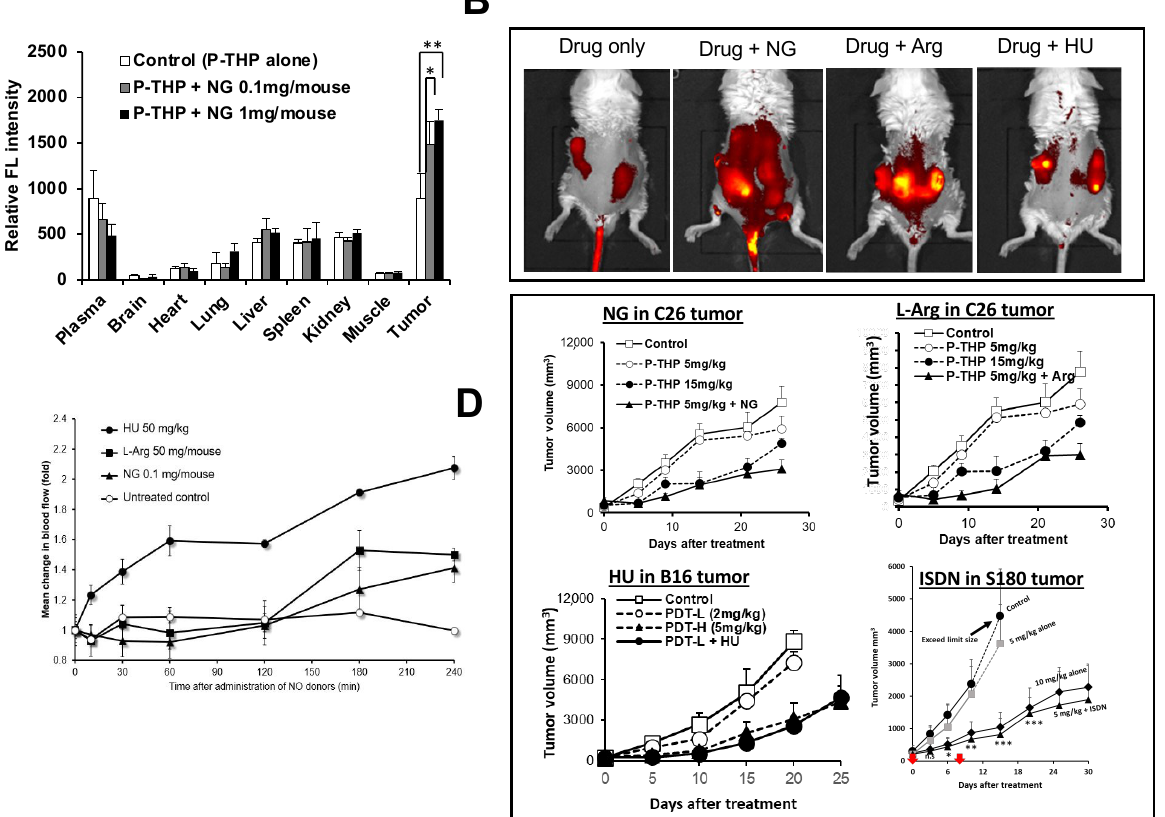
Figure 3. Enhancement of tumor drug accumulation and therapeutic efficacy by using different nitricoxide (NO) domors in implanted tumor models. We first investigated increased drug delivery in various solid tumors that had been generated via subcutaneous administration of cancer cells (2 × 10 7 cell/mL, 100 µ L/mouse) on the dorsal skin. When tumor diameters measured 10–12 mm, the polymer drug was administered intravenously (iv) in combination with NO donors, e.g., nitroglycerin (NG) at the dose of 0.1–1 mg/mouse as an ointment, L-arginine (L-Arg) at 50 mg/mouse intraperi- toneally (ip), hydroxyurea (HU) at 50 mg/kg ip, and isosorbide dinitrate (ISDN) at 30 mg/kg, ip. After 24 h of drug treatment, drug accumulation was measured in tumor tissue homogenate by means of fluorescence spectroscopy ( A ) and in vivo imaging by IVIS (IVIS XR; Caliper Life Sciences) ( B ). The improved blood flow in S180 tumors with different NO donors was measured by using a laser Doppler flowmeter (ALF21: Advance Co., Ltd.) ( C ). ( D ) Enhancement of the antitumor effect of various nanomedicines including P-THP [ N -(2-hydroxypropyl) methacrylamide (HPMA) copolymer conjugated with pirarubicin], PZP [HPMA polymer-conjugated zinc protoporphyrin (ZnPP)], P-PyF (PHPMA polymer-conjugated pyropheophorbide), and SGB-complex [complex formed with styrene- co-maleic acid (SMA) copolymer conjugated with glucosamine and boric acid (BA)] with EPR effect enhancers in different tumor models. Red arrows indicate the (iv) injection point. PDT indicates photodynamic therapy with PZP, L: low dose, H: high dose. Data are expressed as means ± SD. n = 5, * p < 0.05, ** p < 0.01, *** p < 0.001. For details, please see Islam et al.